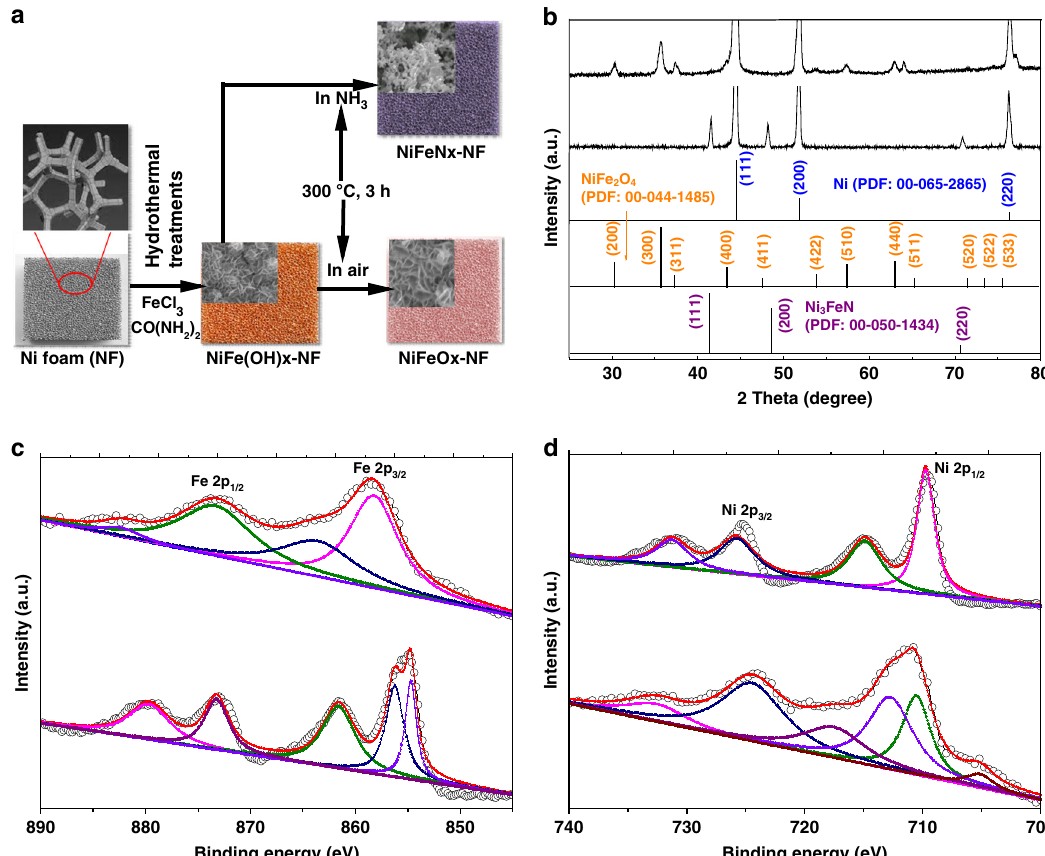
Fig. 1 Synthesis and structure characterization of the catalysts. a Schematic illustration for the synthesis of NiFeN x -NF and NiFeO x -NF catalysts. b XRD patterns of the NiFeO x -NF and NiFeN x -NF catalysts in comparison with standard XRD patterns. c XPS Fe 2p spectra and d Ni 2p spectra of the NiFeO x -NF and NiFeN x -NF